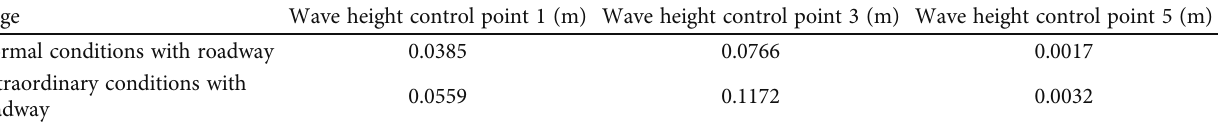
Table 5: Average wave height referred to below average low-tide level for control points 1, 3, and 5.